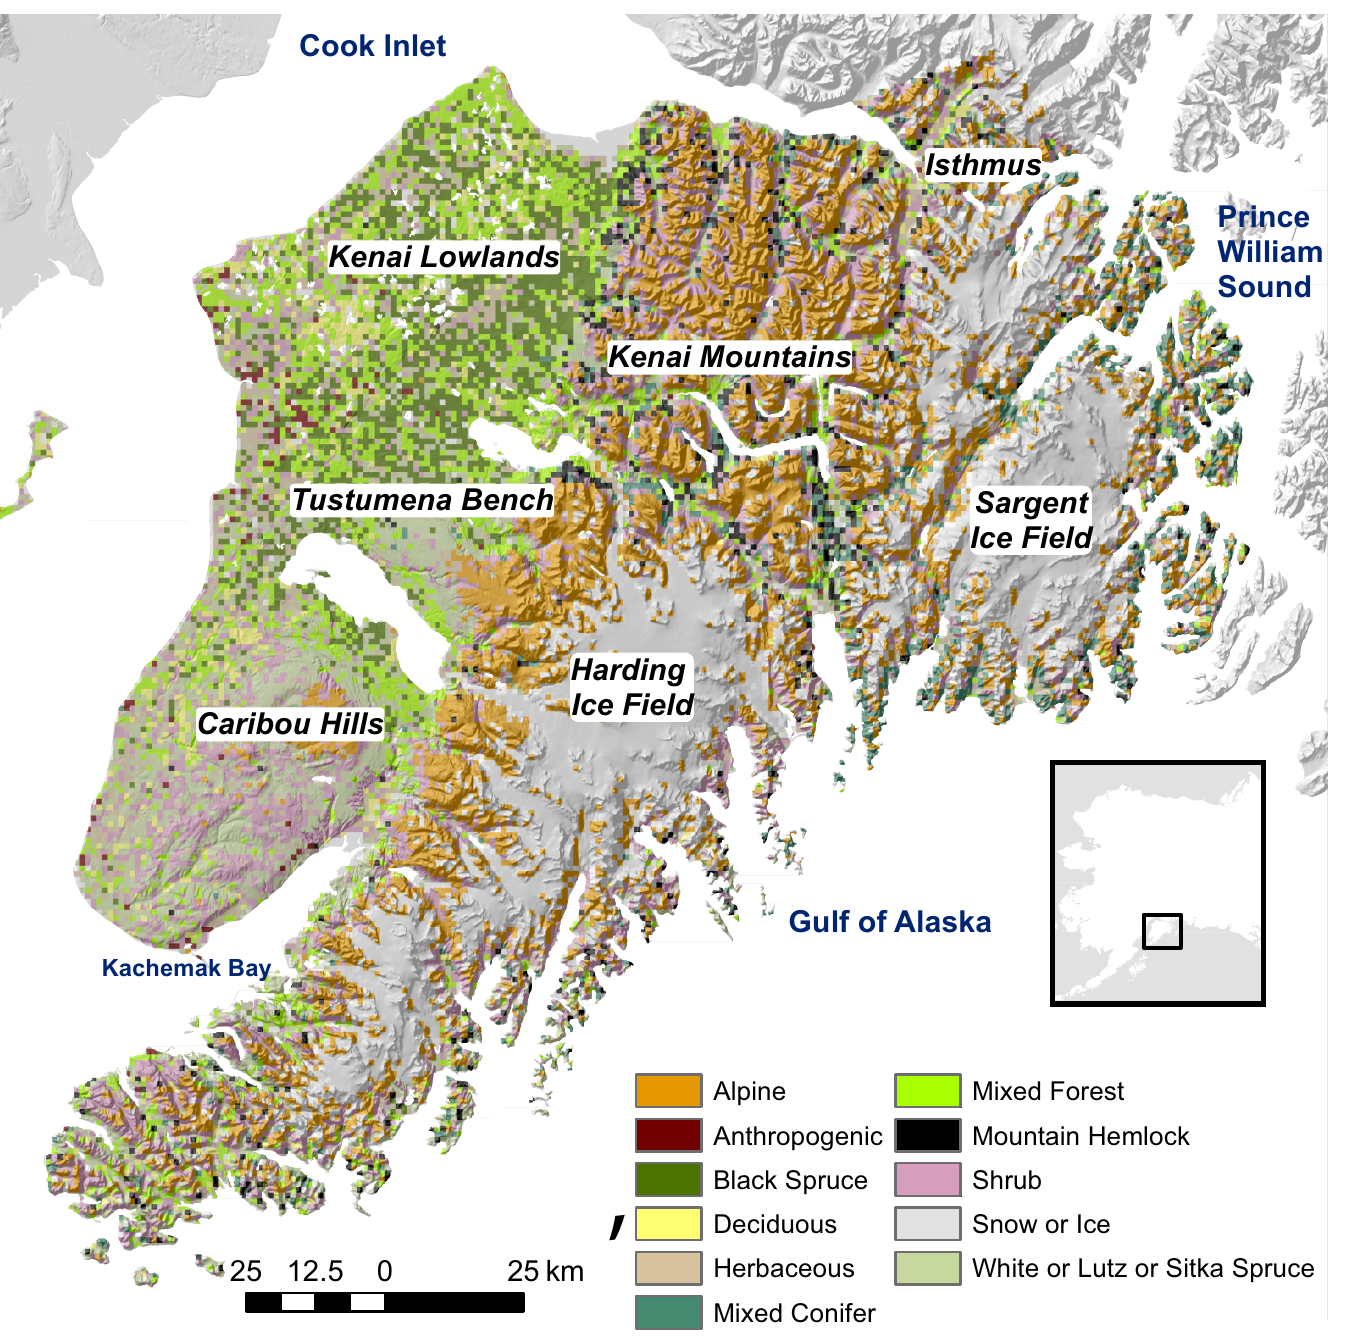
Fig 1. Study area. The Kenai Peninsula in south-central Alaska is separated from the adjacent mainland by a ~16-km wide isthmus. The Kenai Mountains run southwest to northeast. The Kenai Lowlands and areas west of the Kenai Mountains are characterized as boreal forest. The eastern Kenai Peninsula is characterized as Pacific maritime rainforest. Three federal land agencies administer ~75% of the